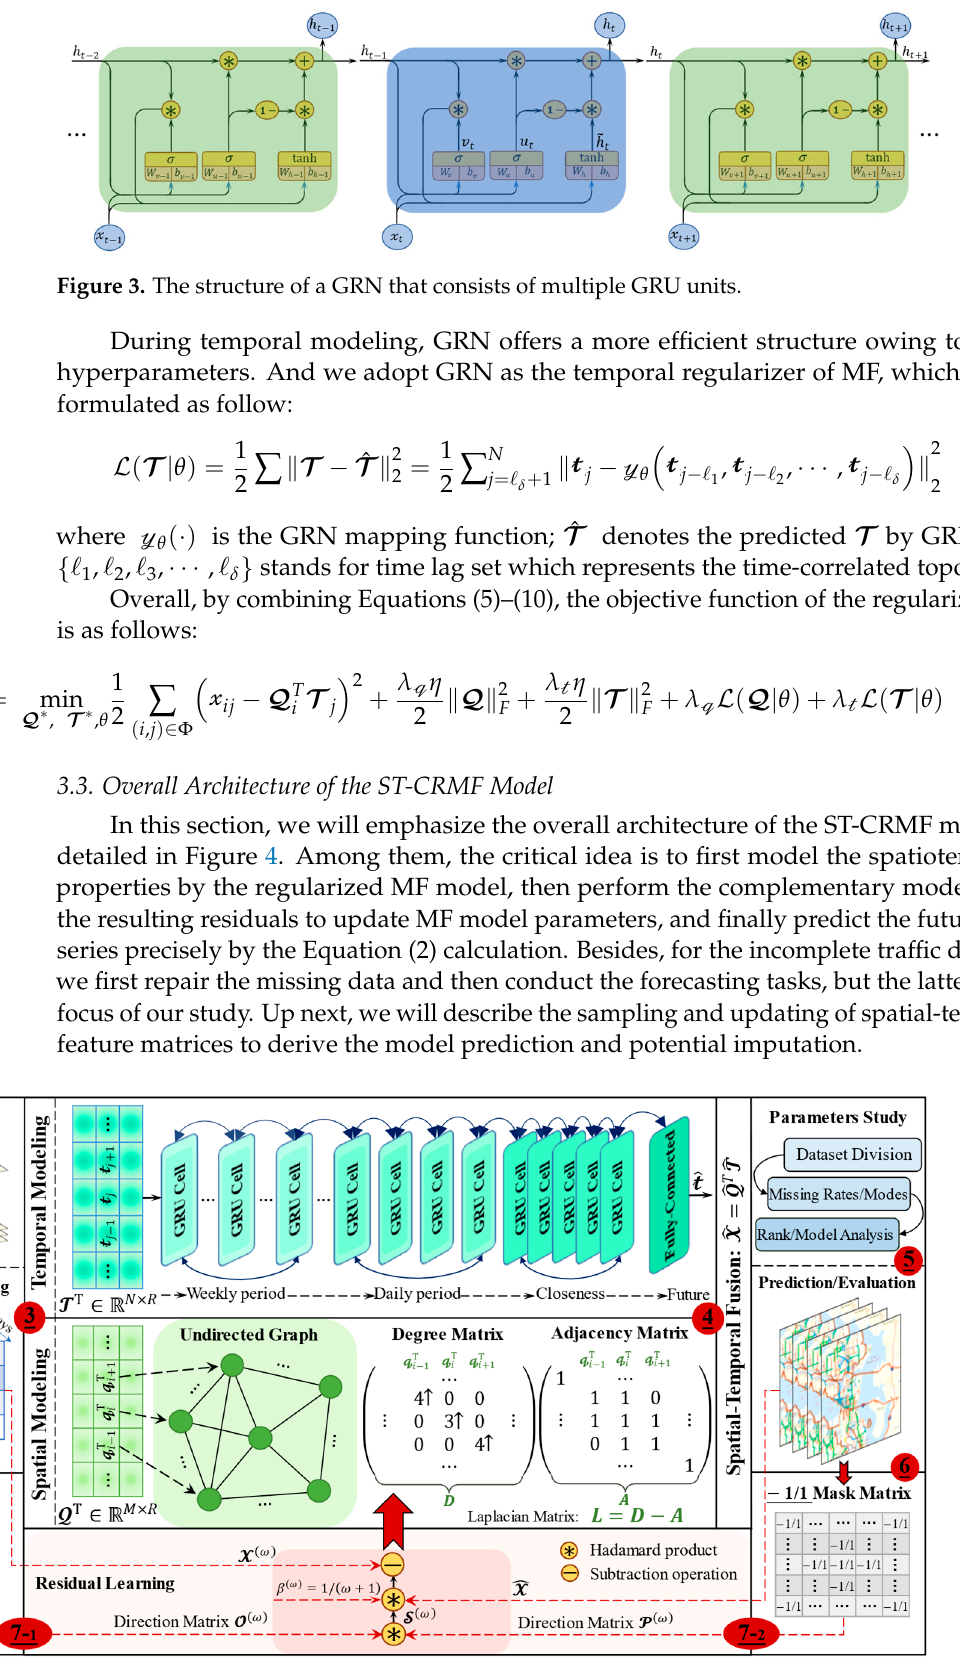
Figure 4. Architecture description and flow of the ST-CRMF